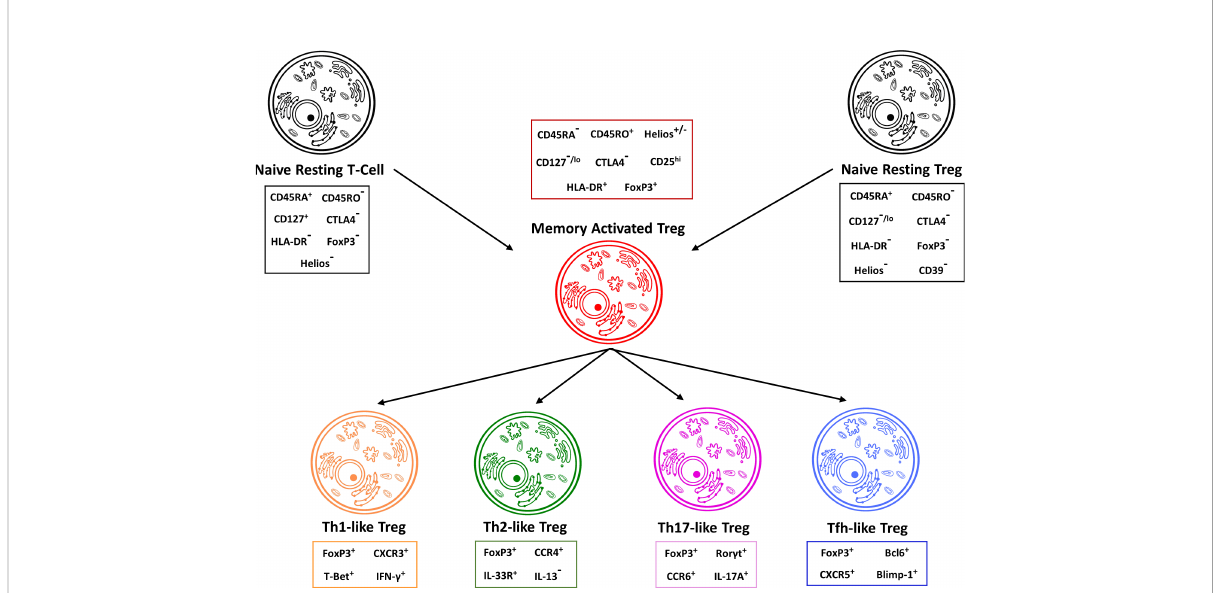
FIGURE 2 Treg cells can be divided in distinct subgroups. Treg cells can further be subdivided into memory activated, Th1-like, Th2-like, Th17-like and Tfh-like regulatory T cells. Both naïve CD4+ T cells as well as naïve resting regulatory T cells can differentiate into memory activated Tregs, which then further delineate into their speci fi c regulatory T cell phenotypes. These phenotypes can be differentiated through different expression pro fi les for genes, transcription factors and cytokine production. In addition, the individual regulatory T cell phenotypes have unique immune capabilities and functions. Th17-like Tregs for example are capable of producing IL-17A and have been shown to be over-represented in patients suffering from RA (73,